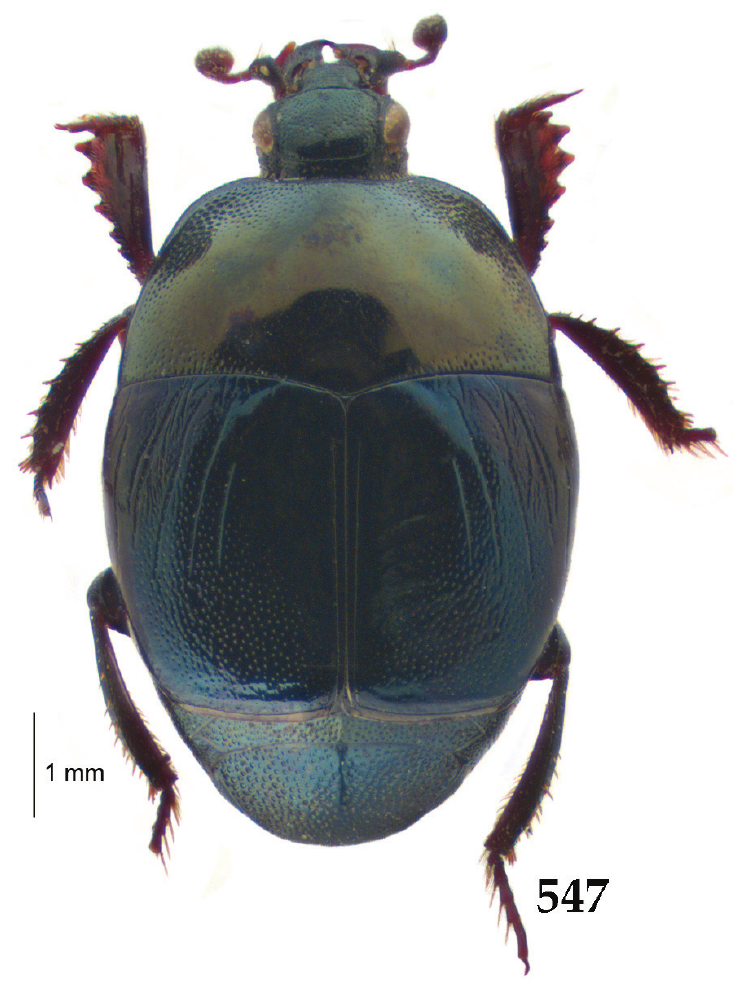
Figure 547. Saprinus ( Saprinus ) splendens (Paykull, 1811) habitus, dorsal view. Feam (under dead cane toad) (QM); 3 specs., Caloundra, 28.x.1913, H. Hacker; 2 ♀♀ & 6 specs., Bangalee Beach, 23°04'S, 150°46'E, 10 m, 16.–19.xii.1999, D. & I. Cook (dung pitfall) (QM); 2 specs., Cairns District, no date, J.A. Anderson; 1 spec., Bamaga, xii.1983, Sedláček (QM); 1 spec., Cape York Peninsula, Lockerbie area, 13.–27.iv.1973, G.B. Monteith (QM); 1 spec., Cape Flattery Heath, 45 km N of Cooktown, 13.–14. vii.1976, G.B. & S.R. Monteith (QM); 1 spec., Moreton Island, Tertiary Dune nr. Blue Lagoon, 4.–11.xii.1988, S. Hamlet (F.I.T.) (QM); 1 spec., Cairns, Illingworth coll., no date (carrion) (BPBM); 2 specs., Bathurst Head, i.1927, Hale & Tindale (SAMA); 2 specs., Bowen, A. Simson (SAMA); 1 spec., Cairns, no further details (SAMA); 1 spec., Bathurst Head, i.1927, Hale & Tindale (SAMA). Western Australia: 8